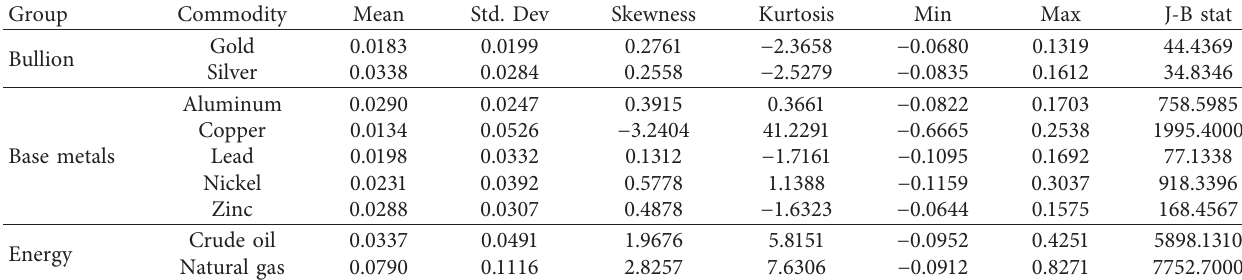
Table 4: Descriptive statistics of selected commodities for spot return.